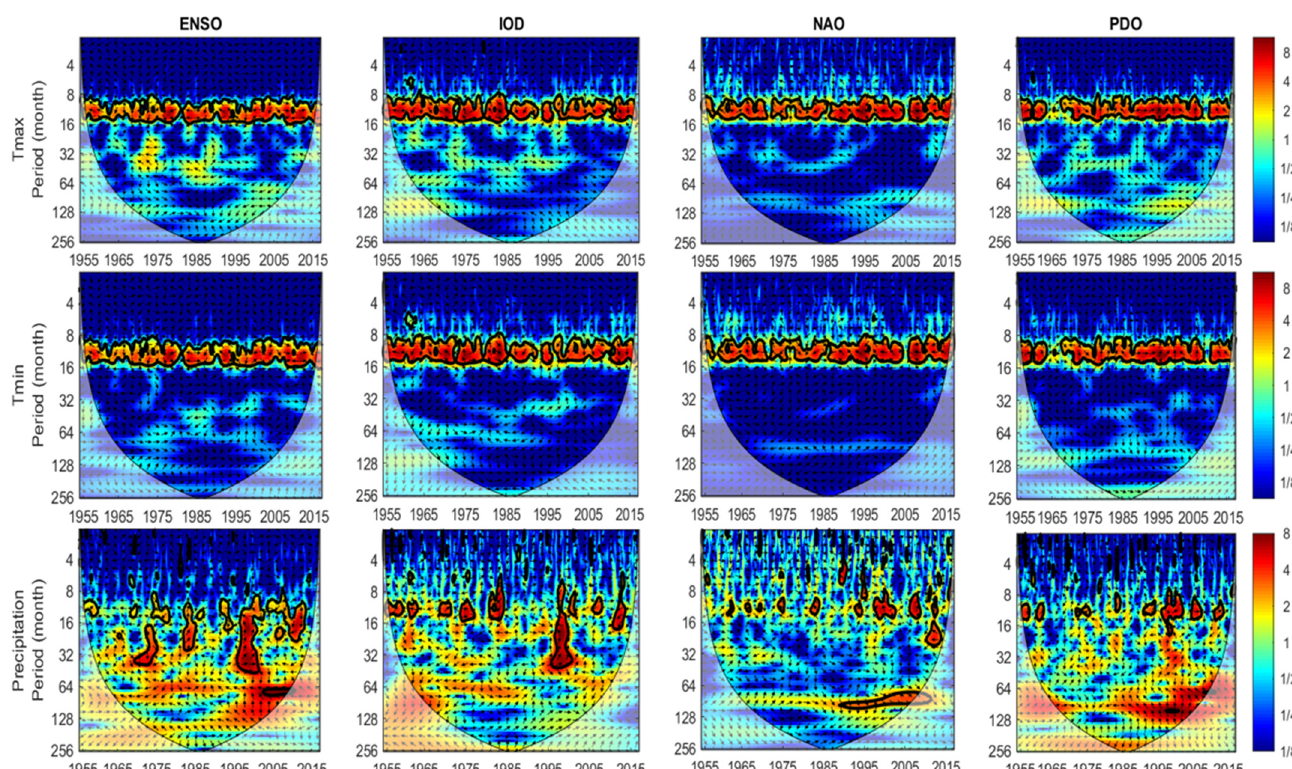
Figure 9. Cross wavelet transform (XWT) of T max , T min and precipitation with ENSO, IOD, NAO and PDO during 1955–2016. Right-pointing arrows indicate that the two signals are in phase, while left is for anti-phase signals. Thick contours denote 5% significance levels against red noise.